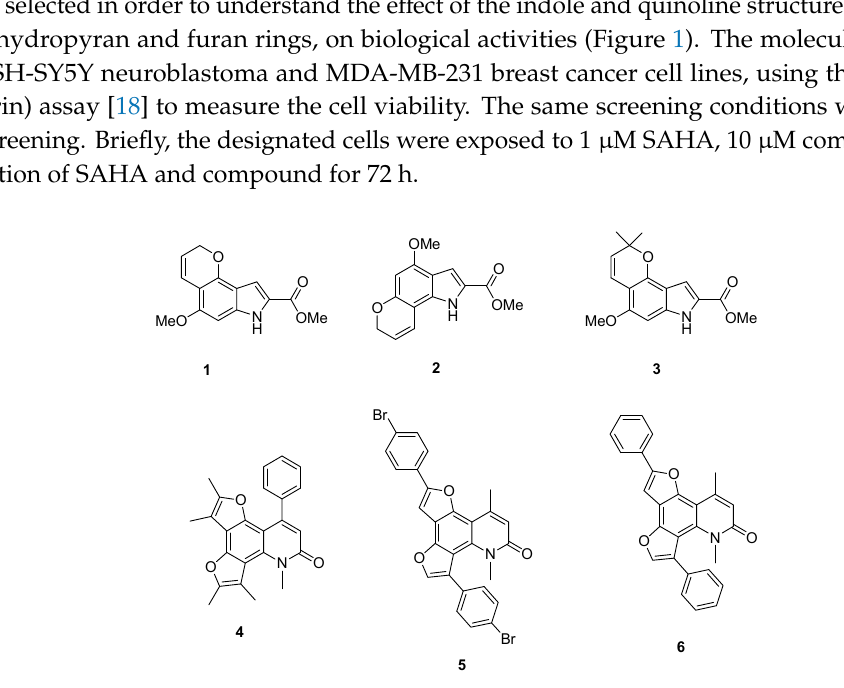
Figure 1. Six compounds from the NK library.